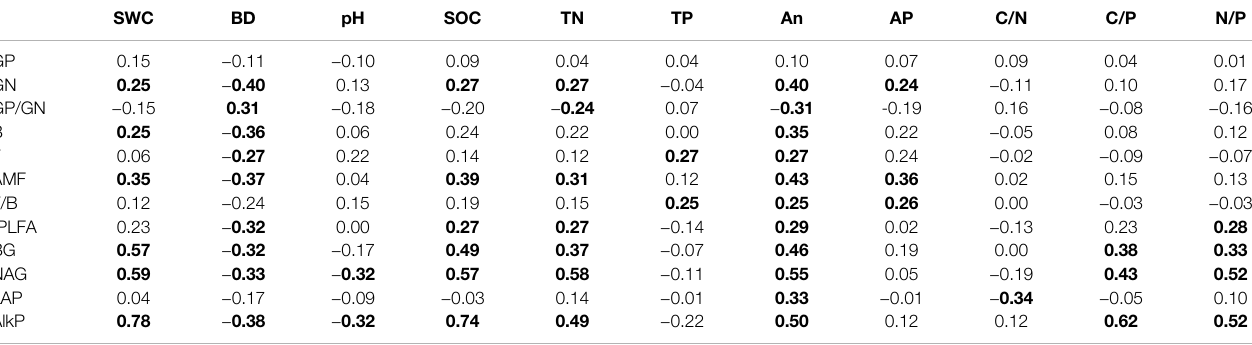
TABLE 3| Pearsoncorrelationcoef fi cient matrix betweenenzyme activities,microbial functional groups, and soilphysicochemicalpropertiesinsoilsfrom under- oroutside- canopy of shrub species Artemisia gmelinii at sites of varying rates of rainfall in the Minjiang River Valley, SW China. SWC BD